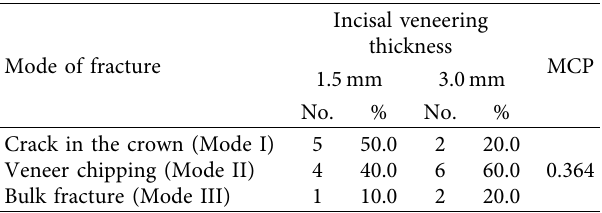
Figure 16: Bar chart showing fracture resistance of the two studied groups. Table 3: Comparison between modes of fracture of total specimens in each incisal veneering